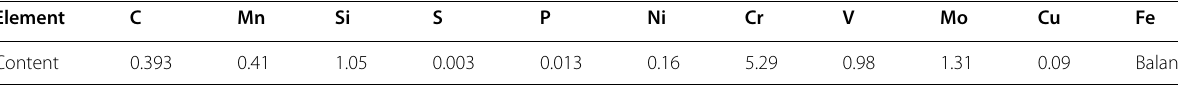
Table 2 Chemical compositions of H13 die steel (mass fraction, %) Element